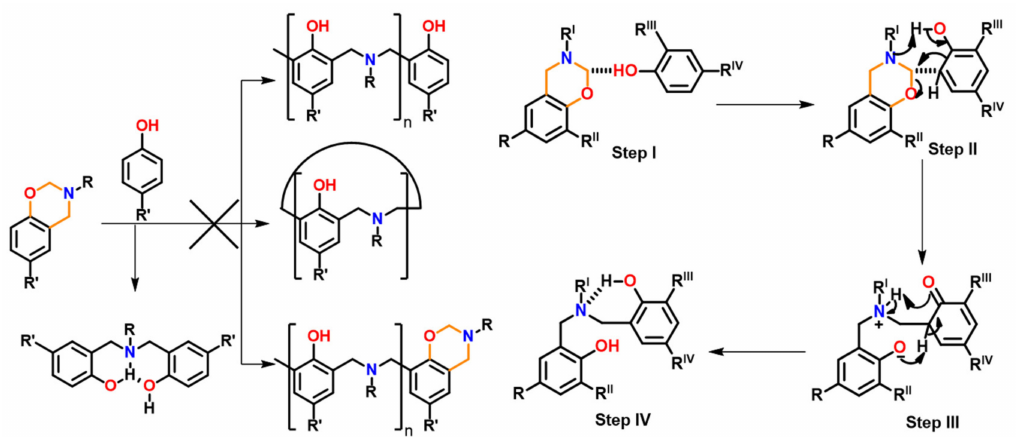
Figure 69. Hypothesis of the molecular mechanism for self-termination of a p -substituted phenol-based benzoxazine